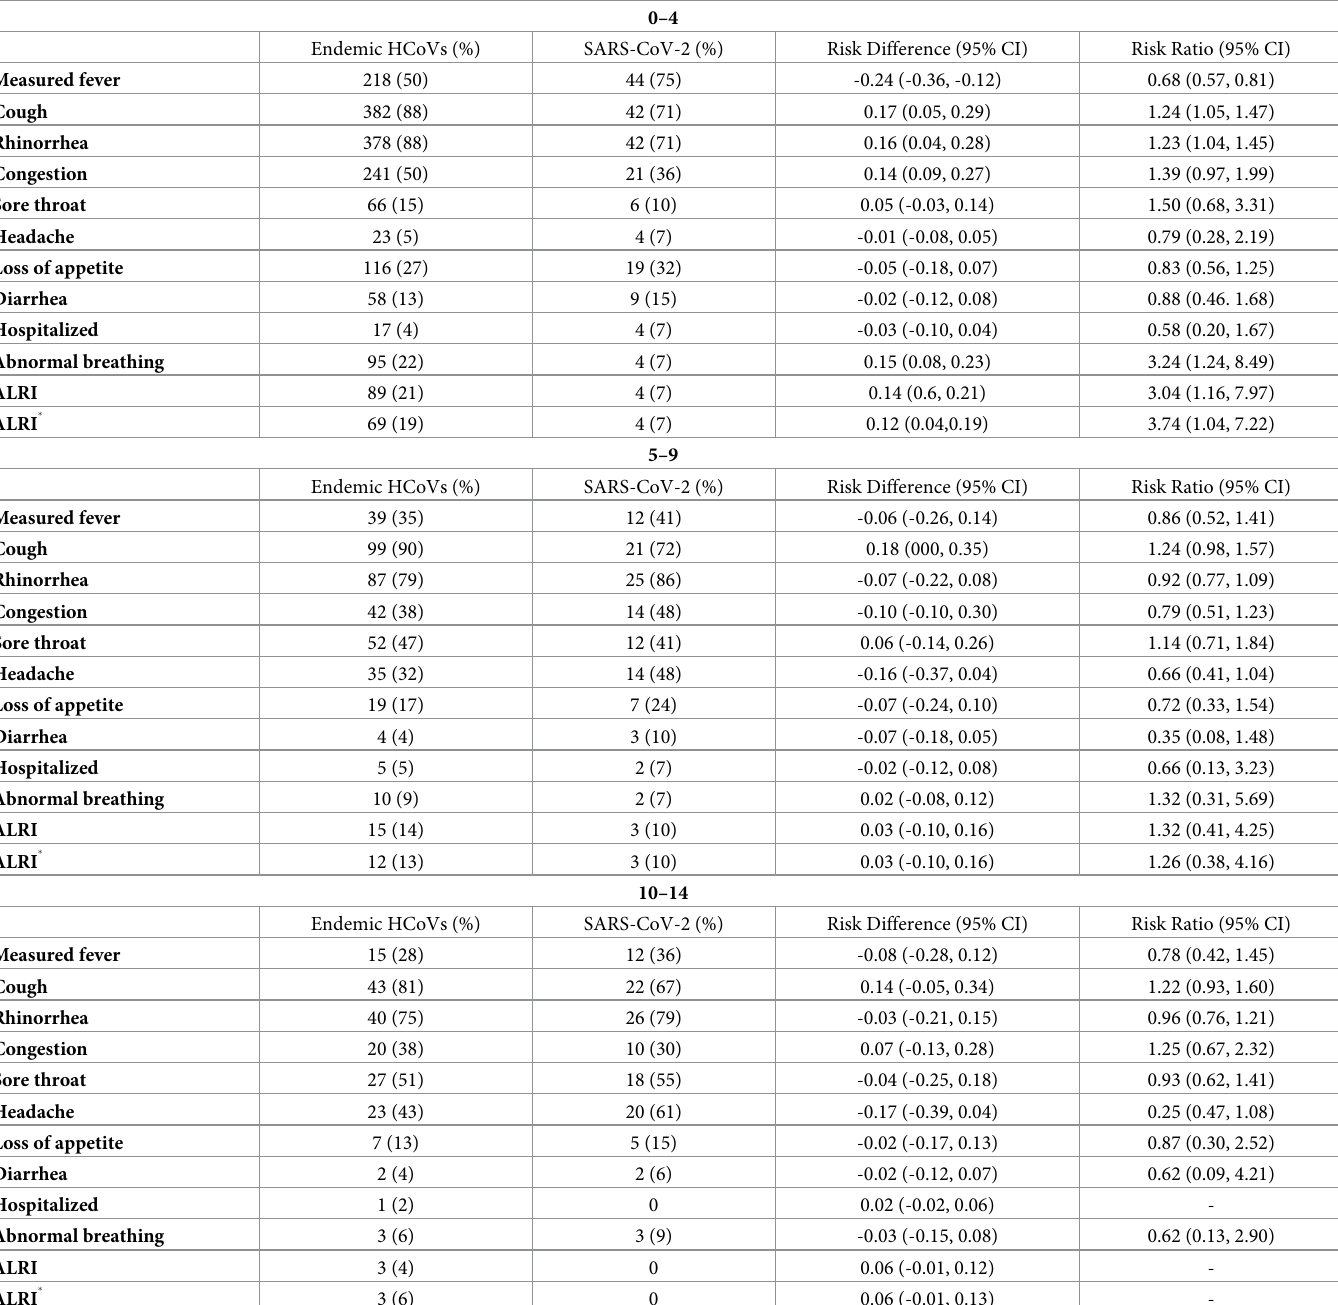
Table 3. Symptom risk between endemic HCoV and SARS-CoV-2 by age